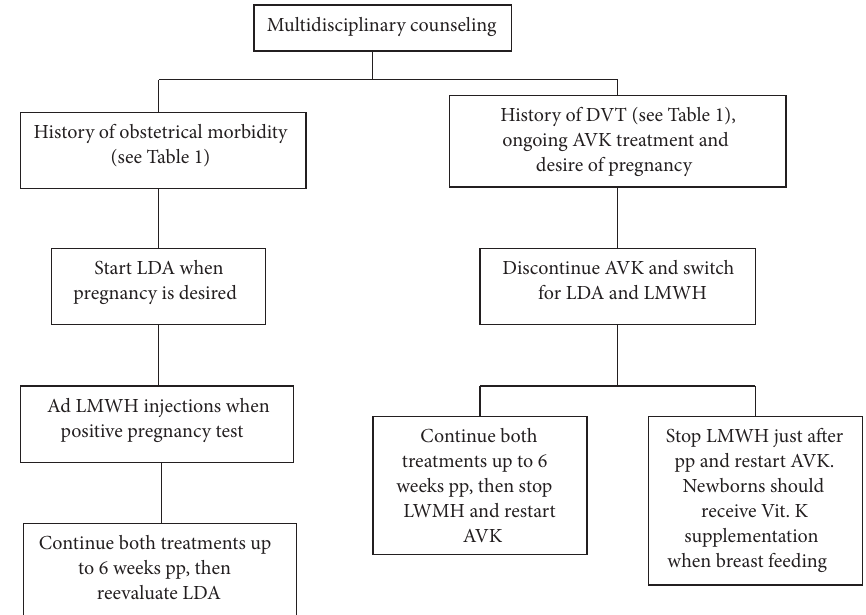
Figure 2: Obstetrical APS first-line